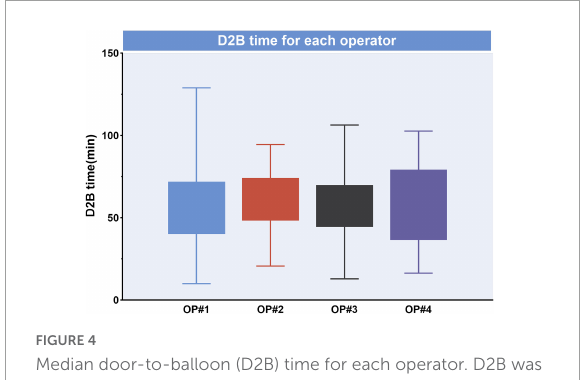
FIGURE4 Median door-to-balloon (D2B) time for each operator. D2B was not significantly different between operators ( p > 0.05), D2B,